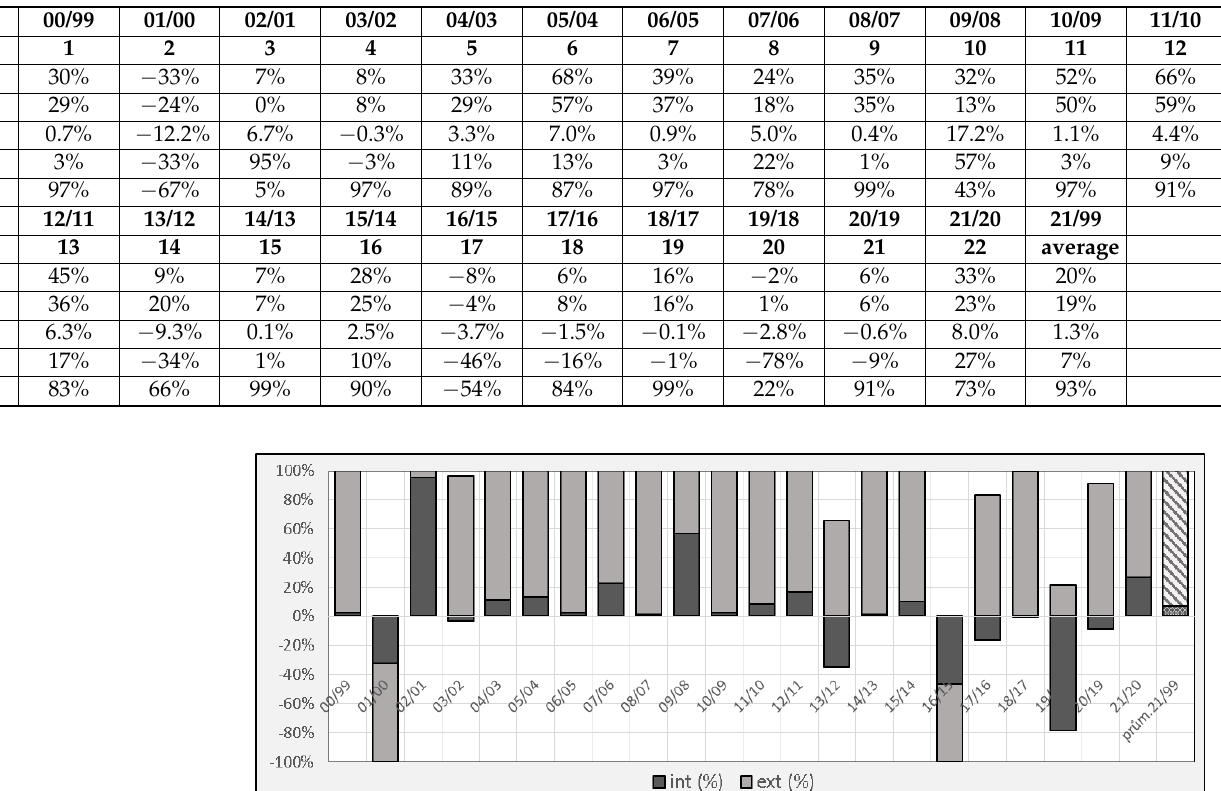
Table 4. Intensity of Apple’s development for the period of 1999–2021.